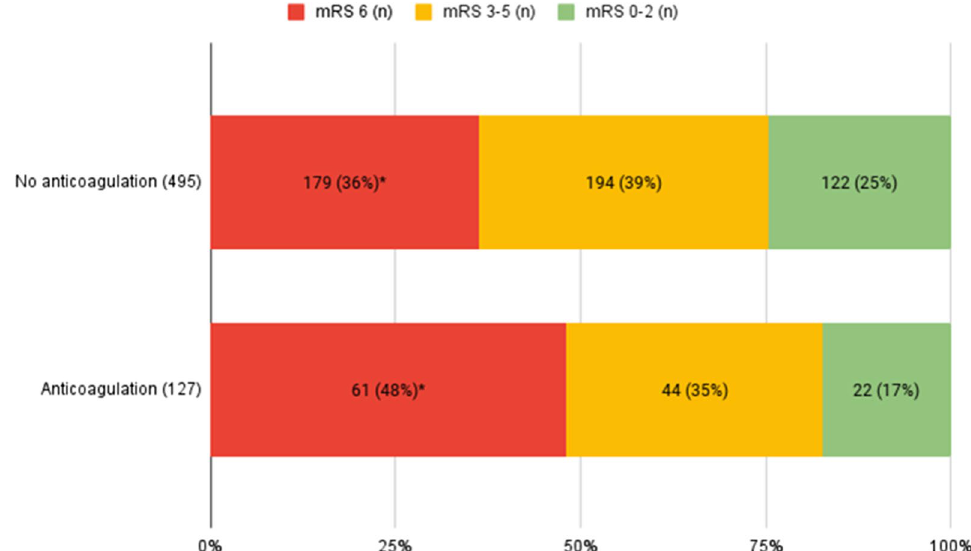
Fig. 3 Three-month mortality and disability rates in anticoagulated versus non-anticoagulated patients, *p